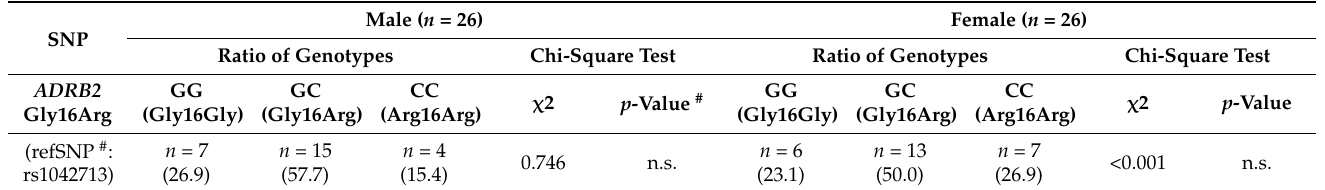
Table 3. Genotype frequencies of ADRB2 Gly16Arg (G/C) polymorphism in male and female subjects.